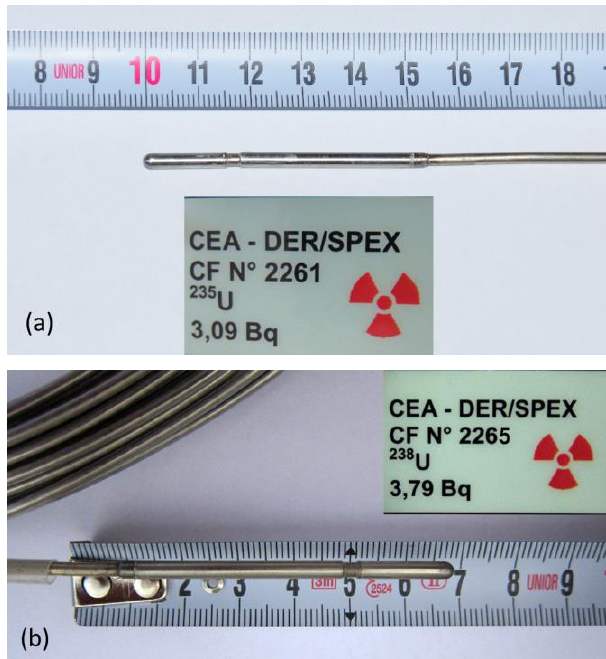
Fig. 1. 235 U miniature fission chamber “FC5” (a) and 238 U miniature fission chamber “FC8” (b).